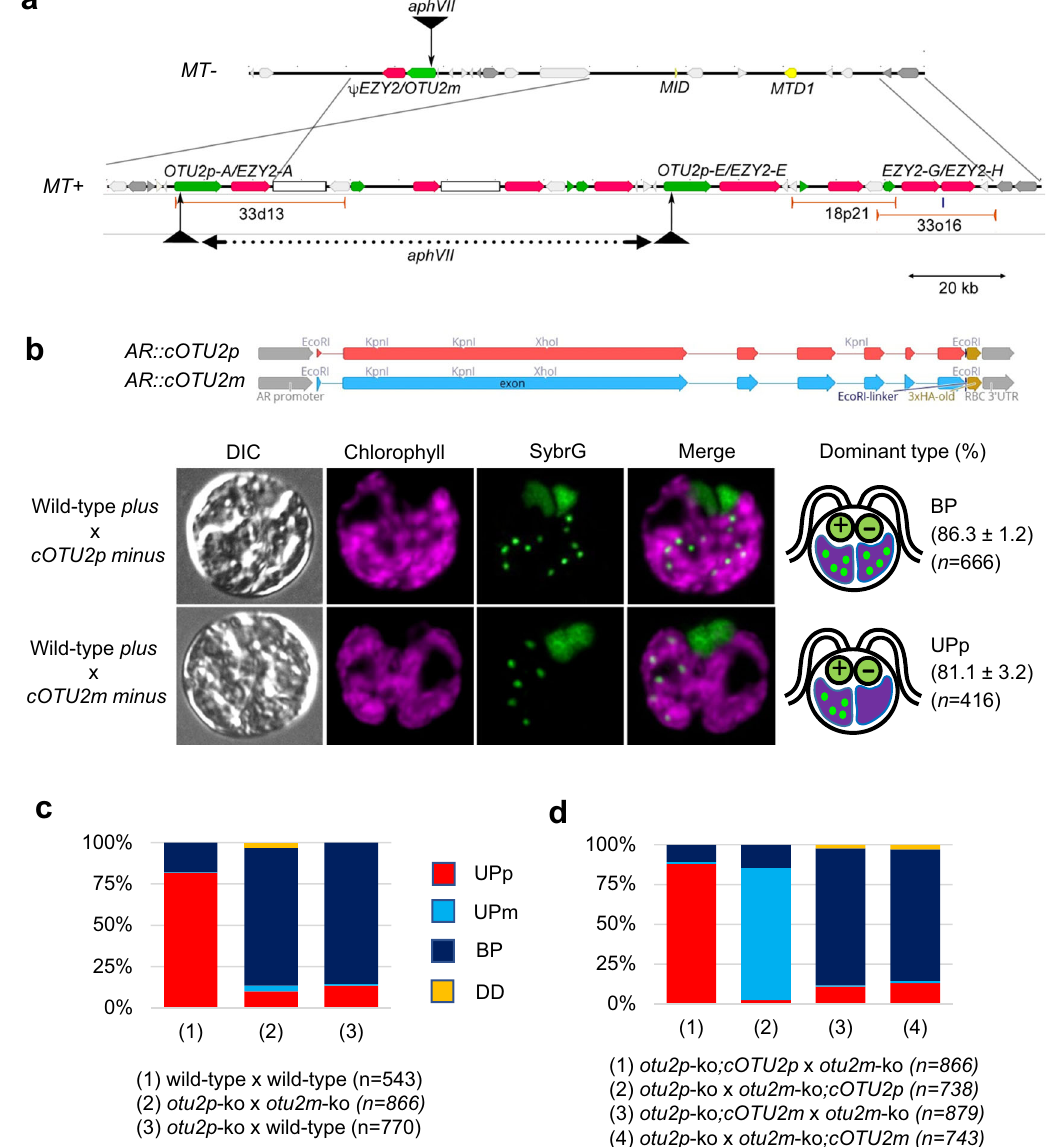
Fig. 2 MT + -linked OTU2p establishes the uniparental inheritance of cpDNA. a R-domain map of the mating-type loci MT − and MT + , focused on the 16-kb repeats unique to MT + . In the 16-kb repeats, OTU2 copies (green) and EZY2 copies (magenta) are alternating. BAC-plasmid clones used in this study are shown as red bars. The integration sites of aphVII delivered by CRISPR-Cas9 resulted in a ~80-kb deletion in MT + (black triangles). b – d The average percentages of uniparental for plus (UPp), uniparental for minus (UPm), biparental (BP), and double degradation without cpDNA staining (DD) were calculated from three biological replicates. Chloroplasts from plus and minus gametes were distinguished by overlapping parent-speci fi c mitochondrial staining of UPp vs. UPm (See Fig. 5c). “ n ” indicates the total number of zygotes examined. Stacked bar graphs show four cpDNA degradation patterns, whose detailed values are provided in Table S3. b Ectopic cOTU2p expression protects minus cpDNA from degradation. The above diagrams show plasmid maps of AR::cOTU2p and AR::cOTU2m . Differential interference contrast and overlaid fl uorescent images of SybrG (green)- stained zygotes with chlorophyll auto fl uorescence (magenta) were taken at 90 min after mating. Bar = 5 μ m. The percentage of the dominant cpDNA degradation pattern for each mating combination was calculated from three biological replicates (mean ± s.d.) “ n ” indicates the total number of zygotes examined. c Zygotes lacking OTU2p show biparental cpDNA inheritance. d Differential expression of cOTU2p between two gametes drives selective cpDNA degradation patterns in otu2 -ko C. reinhardtii homolog of CHIP (Supplementary Fig. 11a, b). The chip mutants underwent normal gametogenesis and carried out normal cpDNA inheritance: 75 – 83% of the homozygous and heterozygous chip zygotes selectively degraded cpDNA, compar- able to wild-type zygotes (Supplementary Fig. 11c), indicating that the CHIP pathway is not required for selective cpDNA degradation.